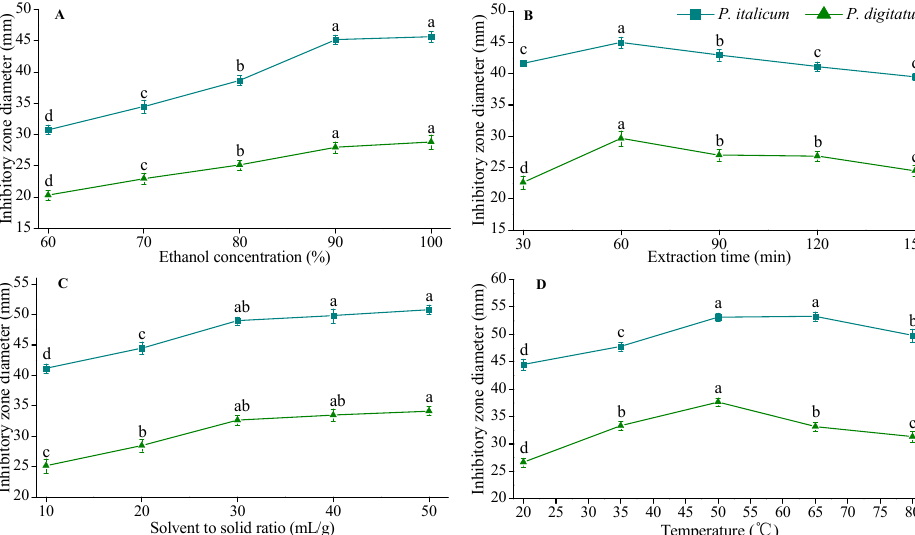
Figure 2. The effects of different extraction parameters on DIZs against P. italicum and P. digitatum . ( A ) Effect of ethanol concentration on DIZs, the other extraction conditions were 60 min extraction time, 20:1 solvent to solid ratio and 20 °C temperature; ( B ) Effect of extraction time on DIZs, the other extract condition were 90% ethanol, 20:1 solvent to solid ratio and 20 °C temperature; ( C ) Effect of solvent to solid ratio on DIZs, the other extract condition were 90% ethanol, 60 min time and 20 °C temperature; ( D ) Effect of temperature on DIZs, the other extraction conditions were 90% ethanol, 60 min extraction time and 30:1 solvent to solid ratio. ( ■ ) DIZs against P. italicum ; ( ▲ ) DIZs against P. digitatum . a–d Significant differences at p < 0.05 level.